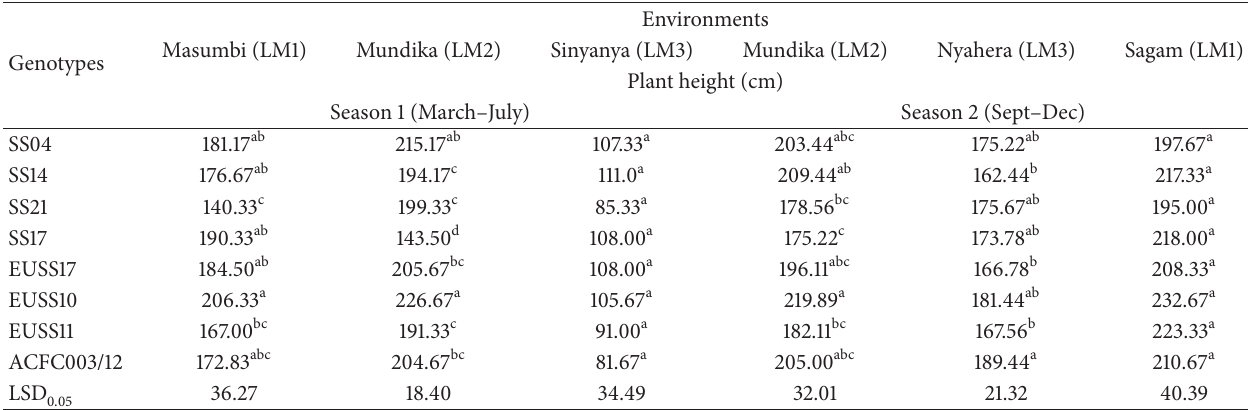
Table 3: Plant height of sweet sorghum genotypes across